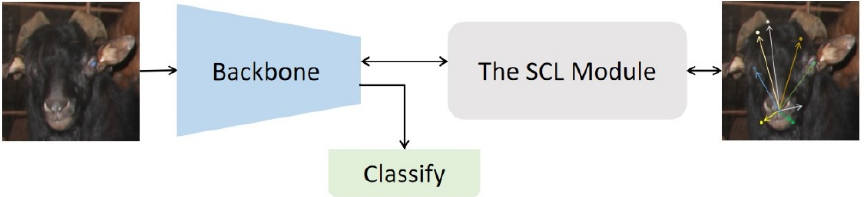
Figure 8. Spatial Context Learning. The SCL module forces the backbone to learn the internal structure of the object.